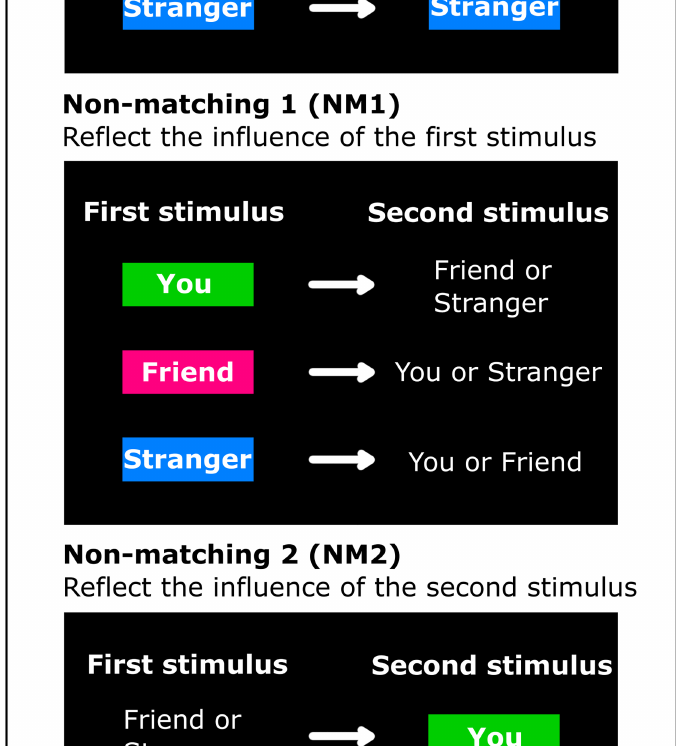
Fig 2. Three types of trials used to analyze the data from both experiments. In matchingtrials face and label corresponded with one another. In non-matching trials they did not correspond. There are two ways to